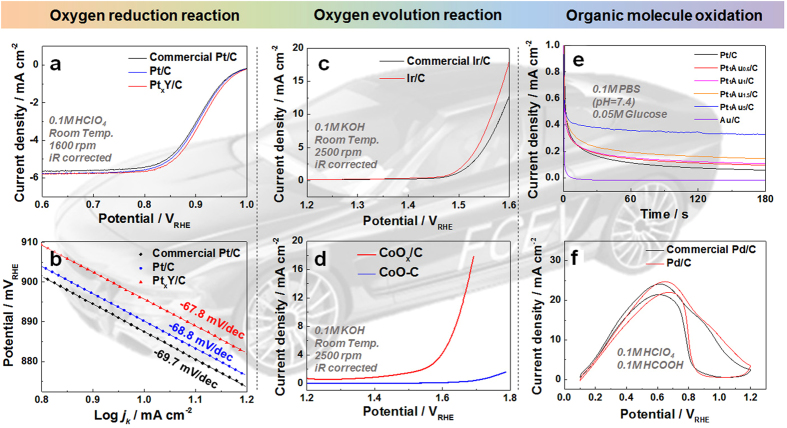
Evaluation of NP/C electrochemial activity.(a) Polarization curves and (b) Tafel plots for ORR on Pt/C, PtxY/C, and commercial Pt/C. (c) OER polarization curves of Ir/C and commercial Ir/C. (d) OER polarization curves of CoxO/C and commercial CoO-C. (e) Chronoamperometry curve for the glucose oxidation reaction on PtxAu1−x/C (0 ≤ x ≤ 1). (f) Polarization curves for FOR on Pd/C and commercial Pd/C.